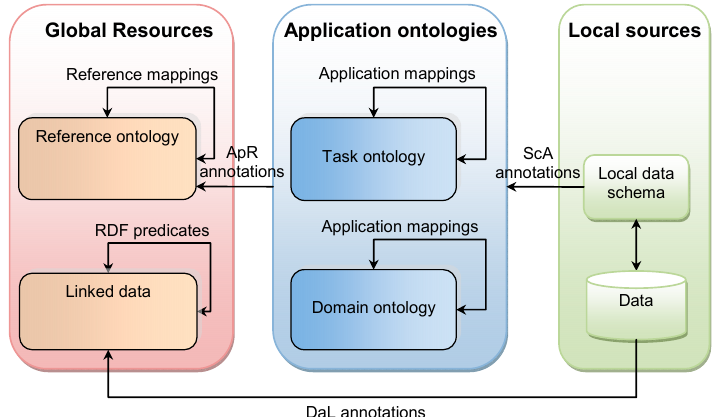
Figure 3. System of resources, semantic annotations and mappings supporting query enrichment. ScA: schema-to-application ontology annotations, ApR: application-to-reference